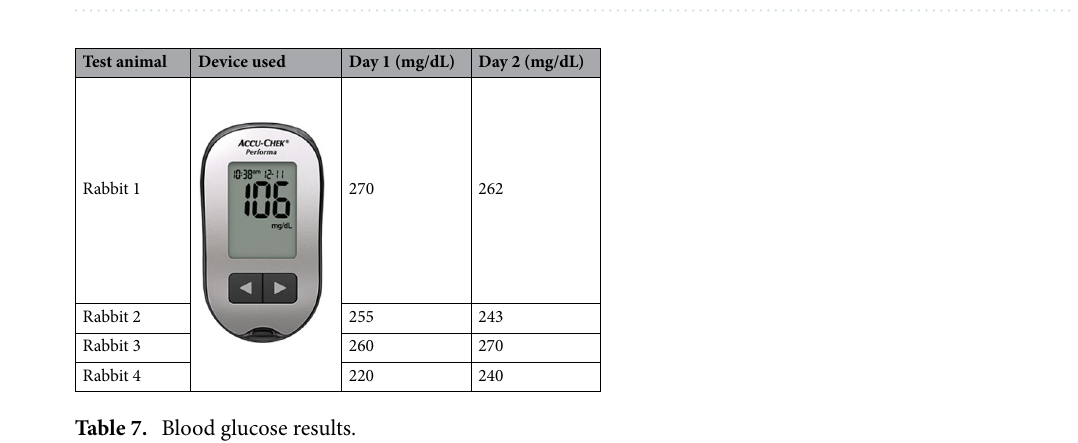
Figure 7. Initial x-rays of rabbits prior to induction of osteoarthritis.